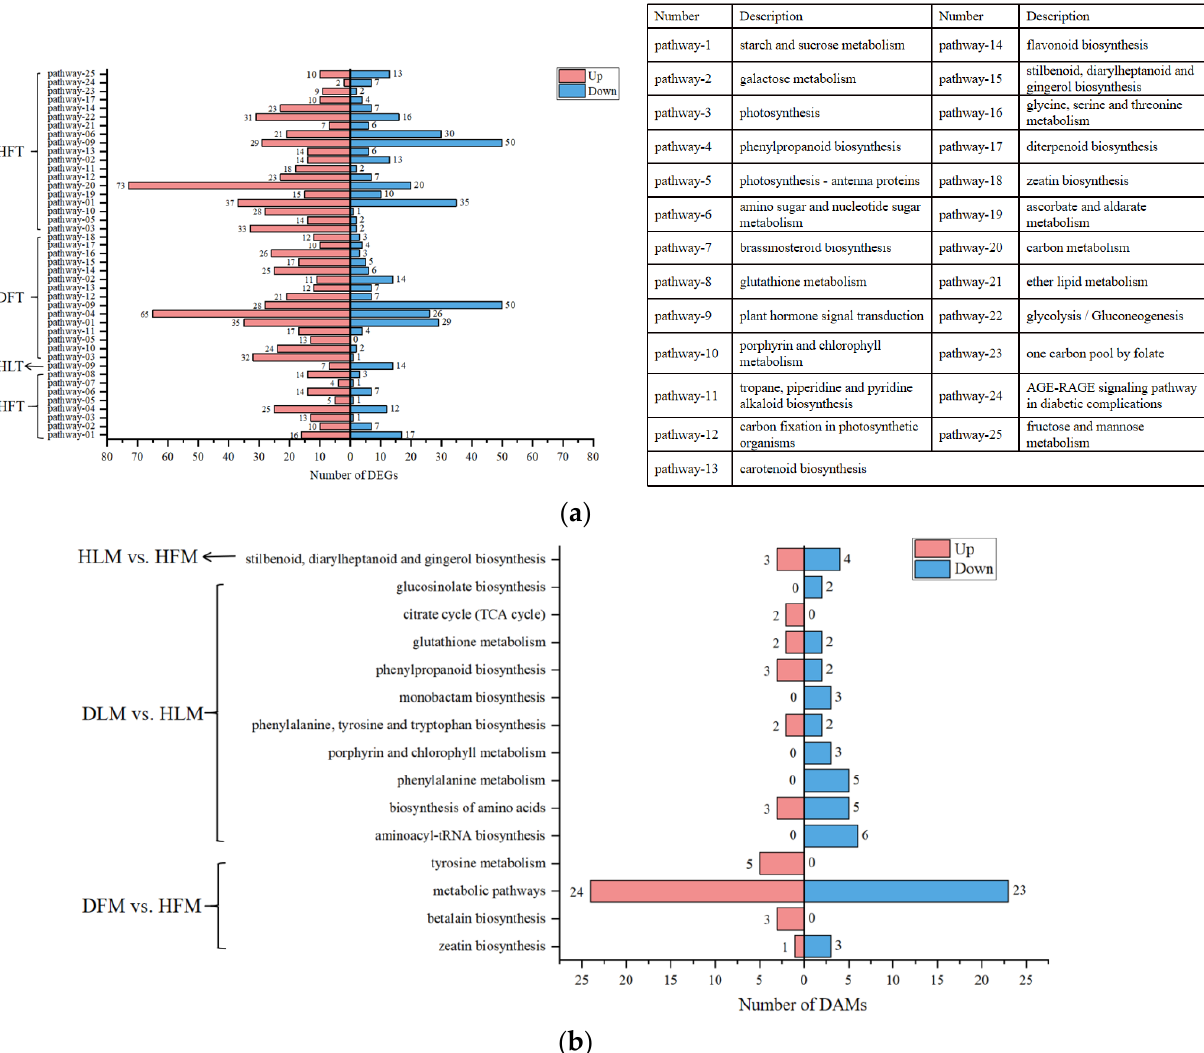
Figure 5. The histogram of KEGG enrichment analysis by differentially expressed genes (DEGs) and differential accumulated metabolites (DAMs) of Citrus reticulata Blanco ‘Shatangju’ in responding to “ Candidatus Liberibacter asiaticus” infection. ( a ) The histogram of KEGG enrichment analysis in DEGs. ( b ) The histogram of KEGG enrichment analysis in DAMs. The horizontal coordinate is the number of DEGs and DAMs enriched in the KEGG pathway, and the vertical coordinate is the KEGG pathway. The number bar of up-regulated genes and metabolites histogram in KEGG nodes is red. The number bar of down-regulated genes and metabolites histogram in KEGG nodes is